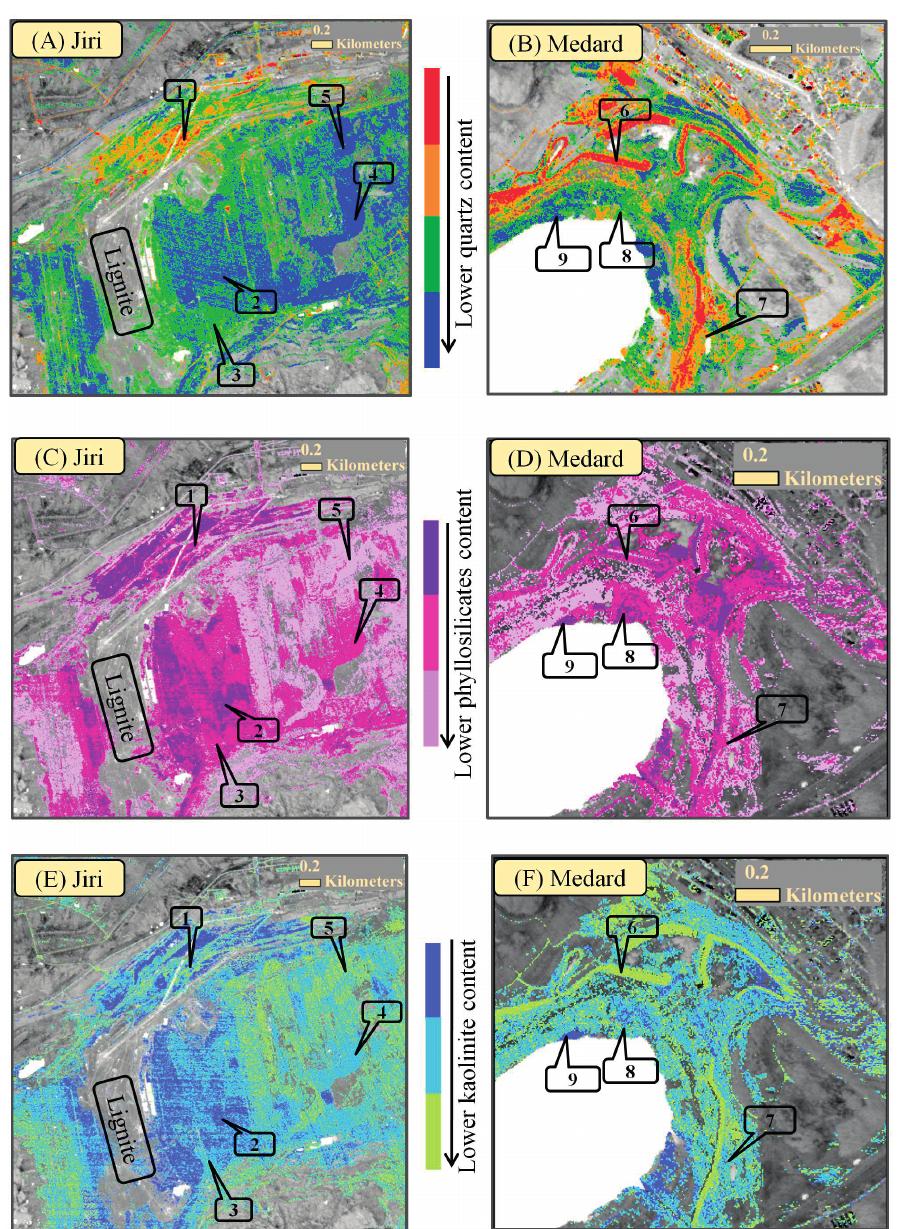
Figure 12. Content of quartz in Jiri ( A ) and Medard ( B ) areas; ( C , D ) Content of phyllosilicates; and ( E , F ) content of kaolinite. Some selected land ROIs are